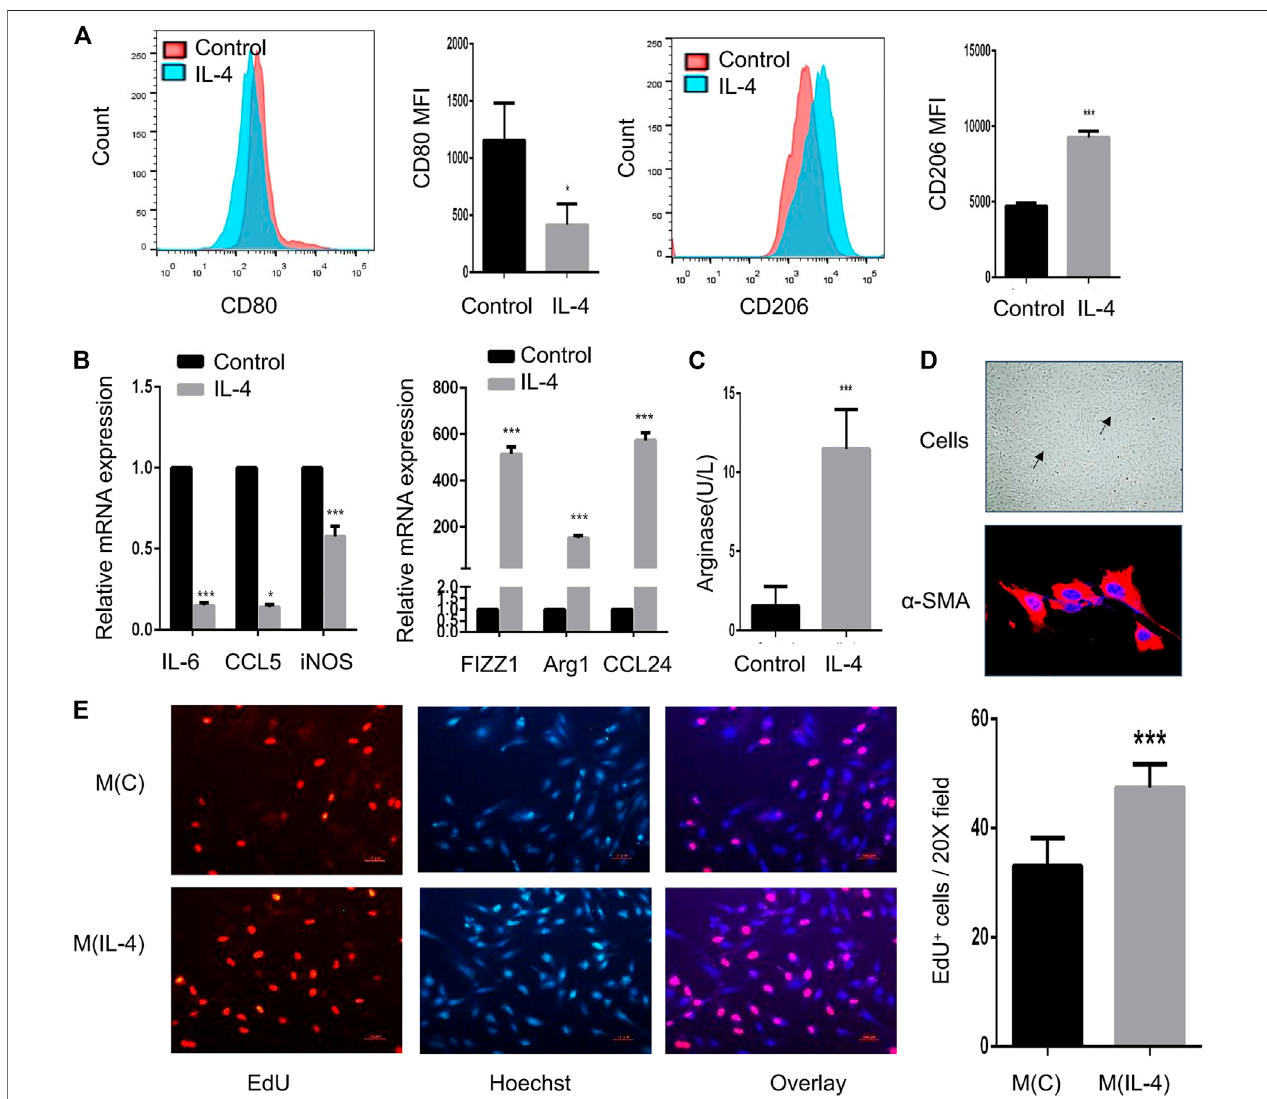
FIGURE 3 | IL-4-induced M2 macrophages promote the proliferation of α -SMA-positive cells in vitro . MH-S cells were treated for 48 h with 20 ng/ml IL-4, and the identi fi cation and function of IL-4-induced M2 macrophages were analyzed (A – C) (A) . Expression of CD80 and CD206 in IL-4-induced M2 macrophages evaluated by fl ow cytometry analysis. The representative histograms and quantitation of the MFI are shown (B) . Expression of IL-6, CCL5, iNOS, FIZZ1, Arg1, and CCL24 in IL-4- induced M2 macrophages evaluated by RT-qPCR (C) . Arginase in IL-4-induced M2 macrophages measured by the arginase assay (D) . Representative image of α -SMA-positive cells under light microscope and immuno fl uorescent staining of α -SMA as shown at a magni fi cation of 40X. Scale bar: 50 μ m. The solid arrow points to thehillandthedottedarrowpointstothevalley (E) .MH-Scellswerestimulatedwith20 ng/mlIL-4for48 handco-culturedwithprimary α -SMA-positivecellsforanother 48 h. M(C) means MH-S cells treated without IL-4 and M(IL-4) means with IL-4. The proliferation of α -SMA-positivecells detectedby EdU incorporation assay asshown at a magni fi cation of 20X. Scale bar: 10 μ m. Quantitation of percentage of EdU + cells per 20X fi eld. (* p < 0.05, *** p < 0.001 vs.